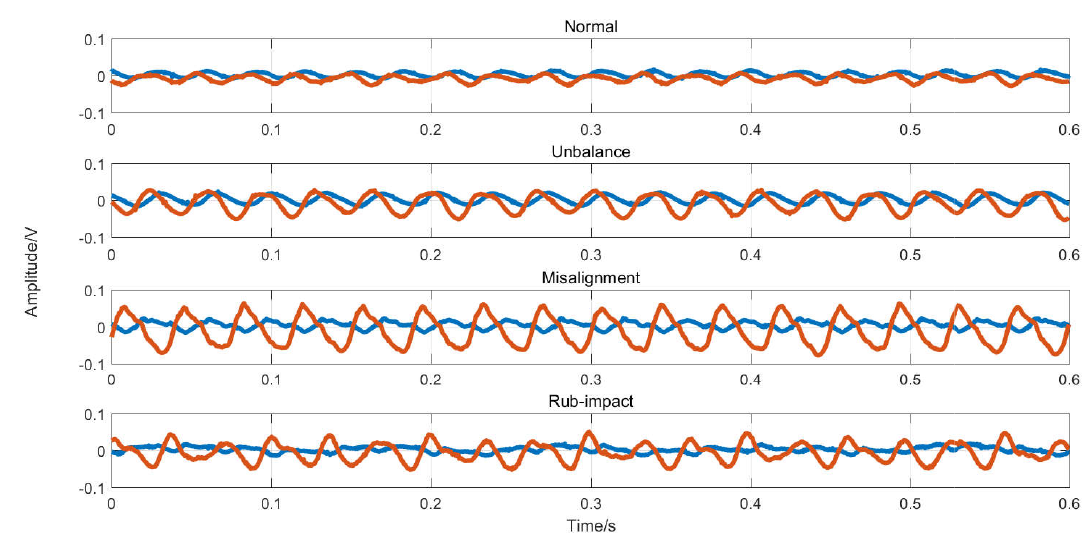
Figure 11. Four classes of vibration signals.